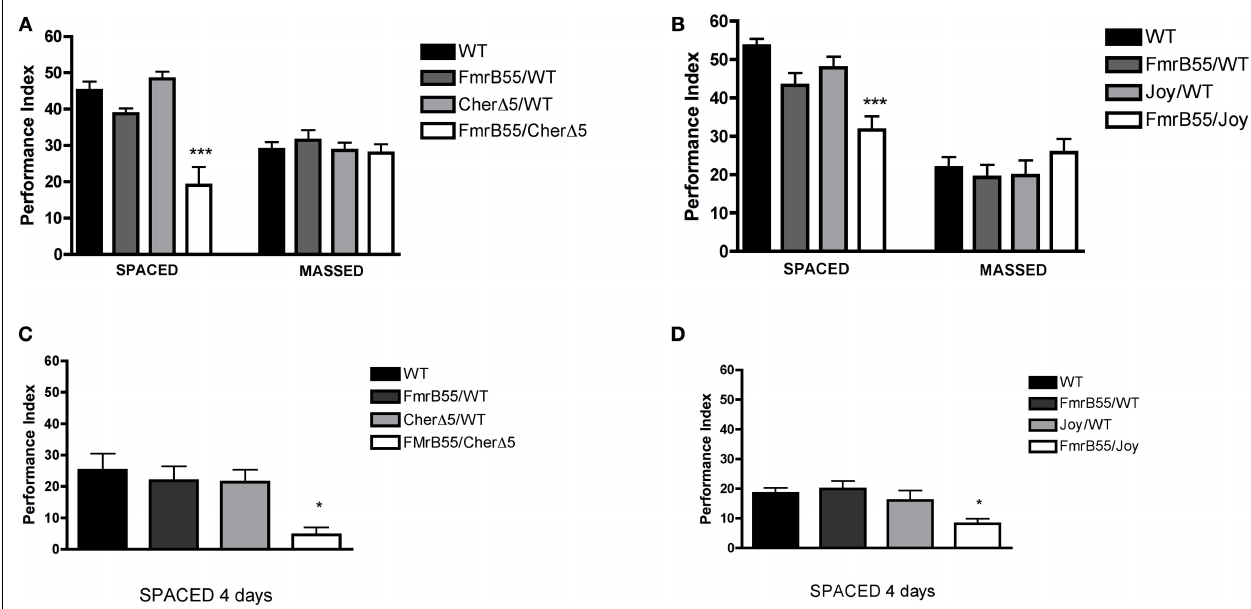
FIGURE 3 | dFmr1 and cheerio interact during long-term memory formation. (A) One-day memory after spaced training is defective in the cher Δ 5 , + / + , dFmr1 B55 double heterozygote ( FMrB55/CherD5 ; P < 0.0001) but not in either single heterozygote ( FmrB55/WT or CherD5/WT ). In contrast, 1-day memory after massed training is normal among the cher Δ 5 , + / + , dFmr1 B55 double heterozygote ( FMrB55/CherD5 ) and both single heterozygotes ( FmrB55/WT or CherD5/WT ). N = 8 PIs per genotype. (B) One-day memory after spaced training is defective in the cher joy , + / + , dFmr1 B55 double heterozygote ( FMrB55/Joy